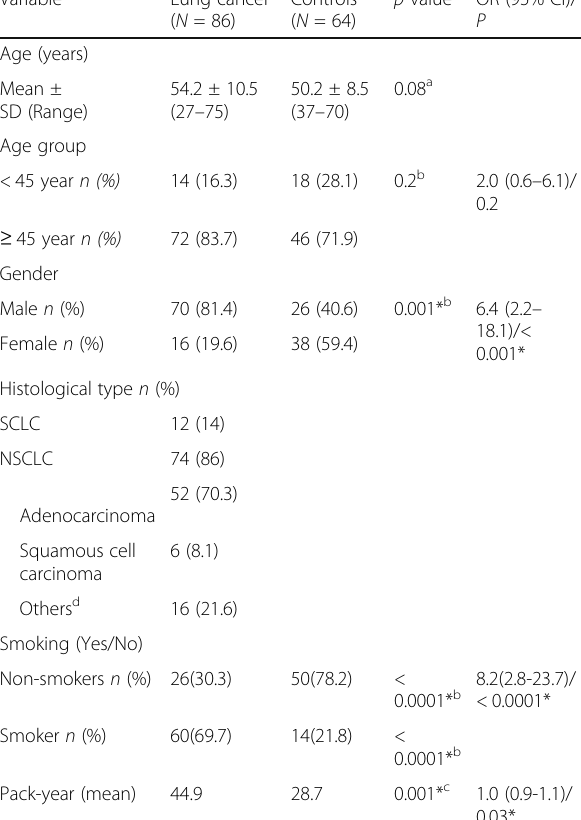
Table 1 General characteristics of the studied lung cancer patients and control subjects